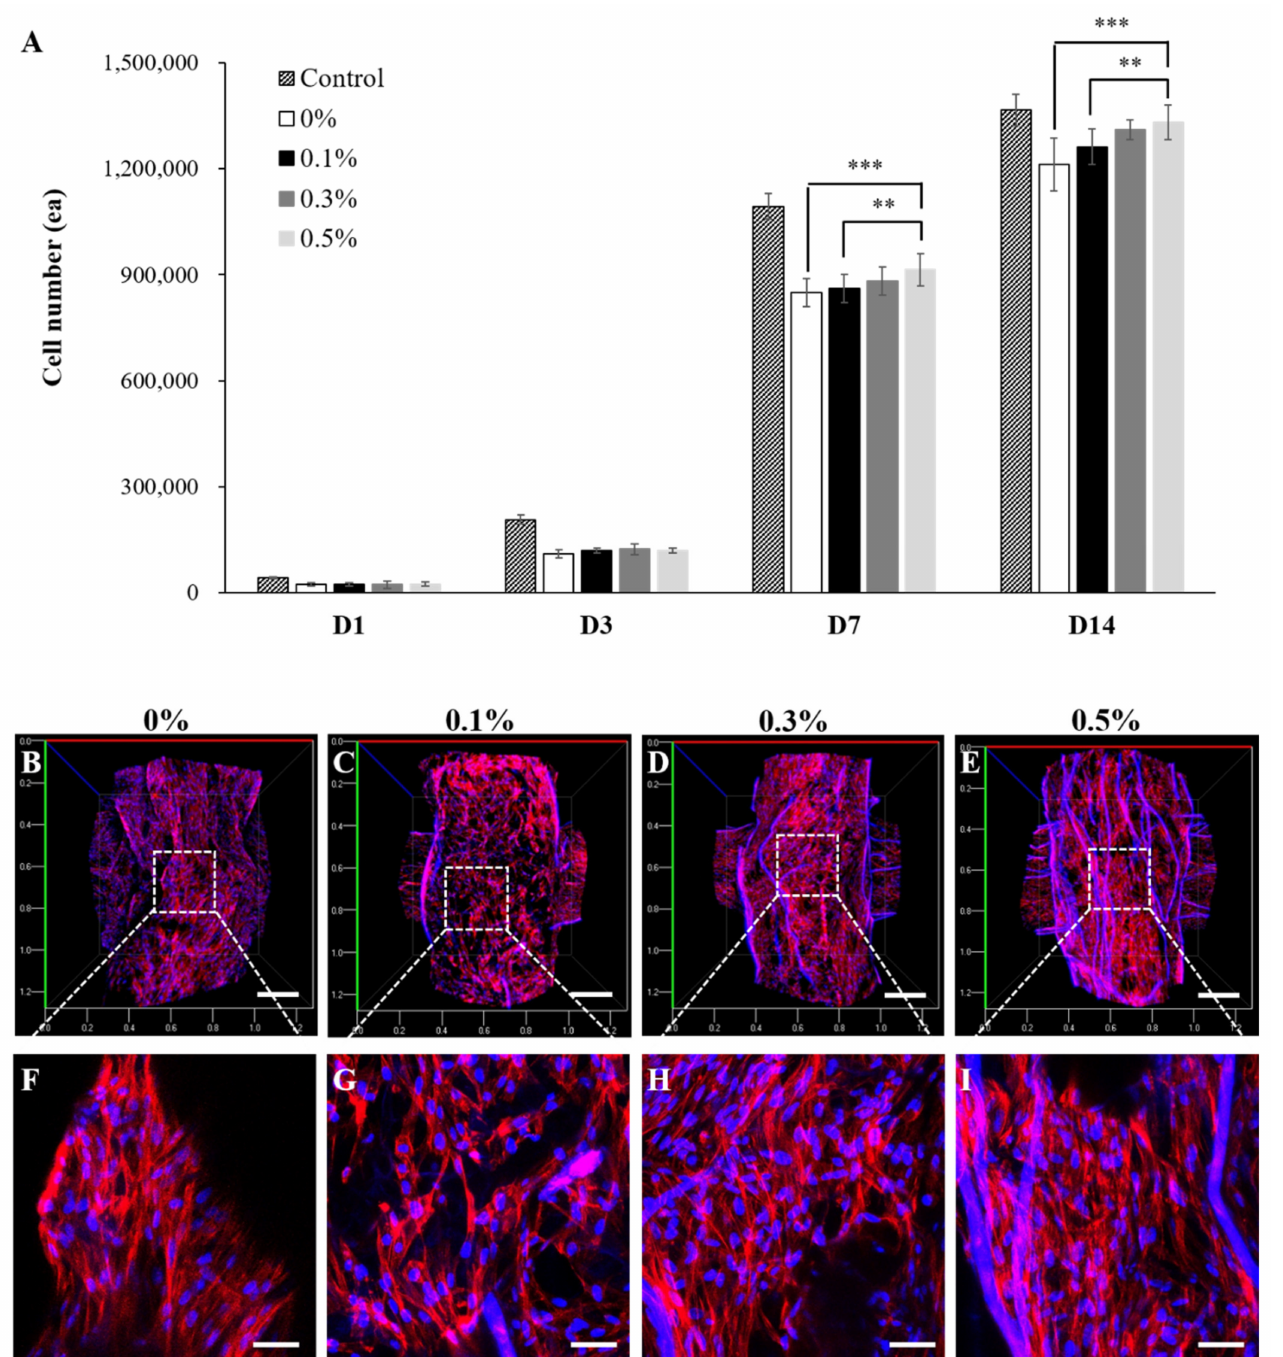
Figure 7. Biocompatibility of the suture fiber reinforced gelatin 3D scaffolds. ( A ) HDFs growth on each 3D printed scaffold over a culture time of up to 14 days ( n = 4) (** p < 0.01, and *** p < 0.001). ( B – I ) Confocal microscopy images of HDFs at 14 days of being cultured on the 3D printed scaffolds prepared using suture fiber contents of ( B , F ) 0%, ( C , G ) 0.1%, ( D , H ) 0.3%, and ( E , I ) 0.5%. (( B – E ) scale bar: 200 µ m; ( F – I ) scale bar: 500 µ m). The nuclei and F-actin of HDFs were stained with DAPI (blue) and phalloidin (red),